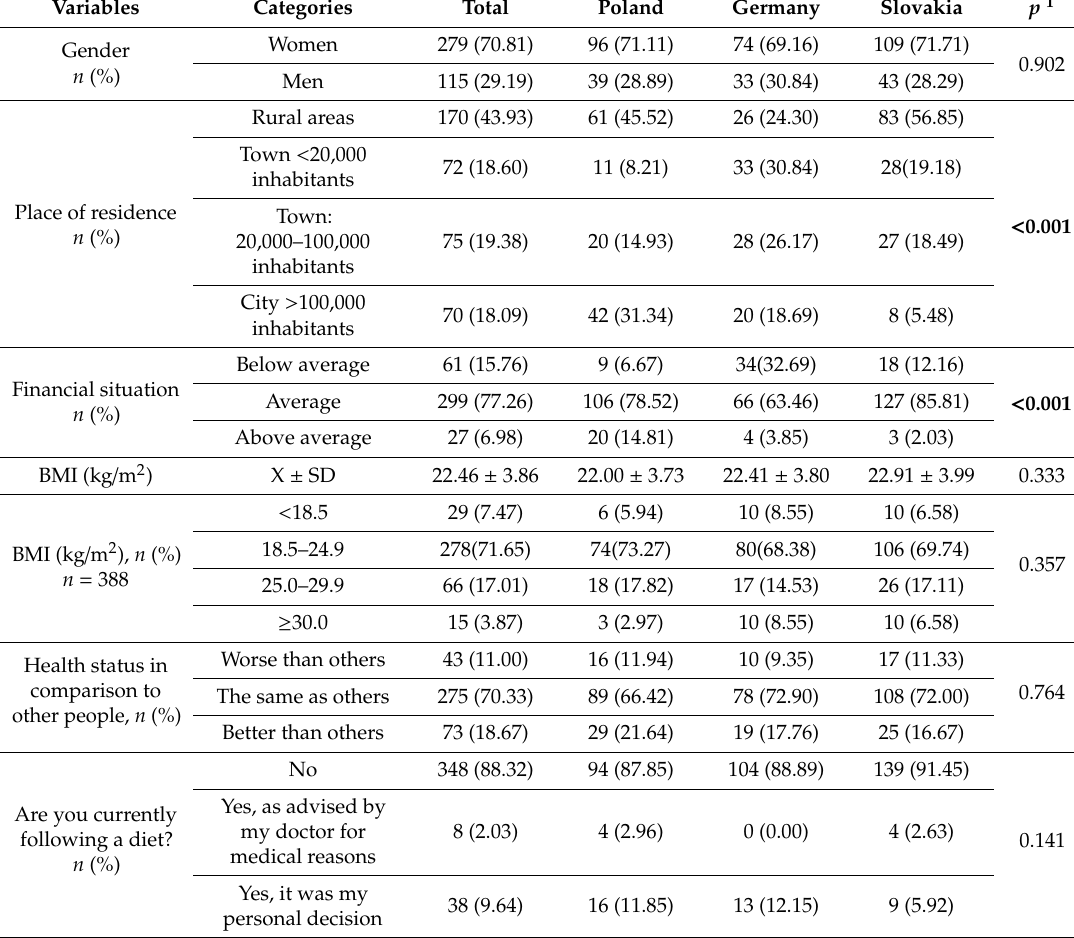
Table 1. Sociodemographic and health characteristics of subject